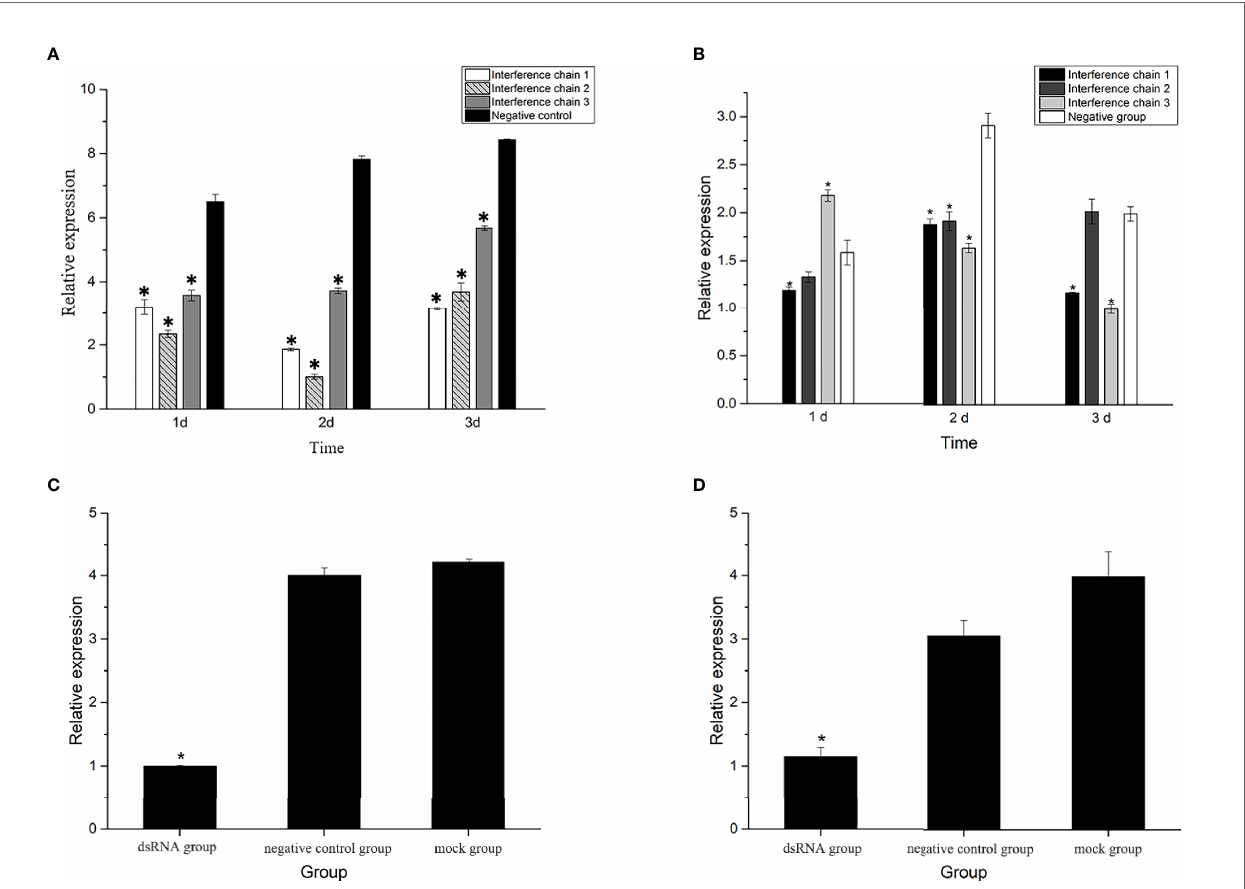
FIGURE 6 | (A) Relative expression of Hc-CDK6 in the gills after RNAi at three time points. (B) Relative expression of Hc-CDK6 in the mantle after RNAi at three time points. (C) Relative expression of Hc-CDK6 in group 2, and the negative control and blank groups. (D) Relative expression of Hc-CCND2 in group 2, and the negative control and blank groups. *Signi fi cance level ( P < 0.05).